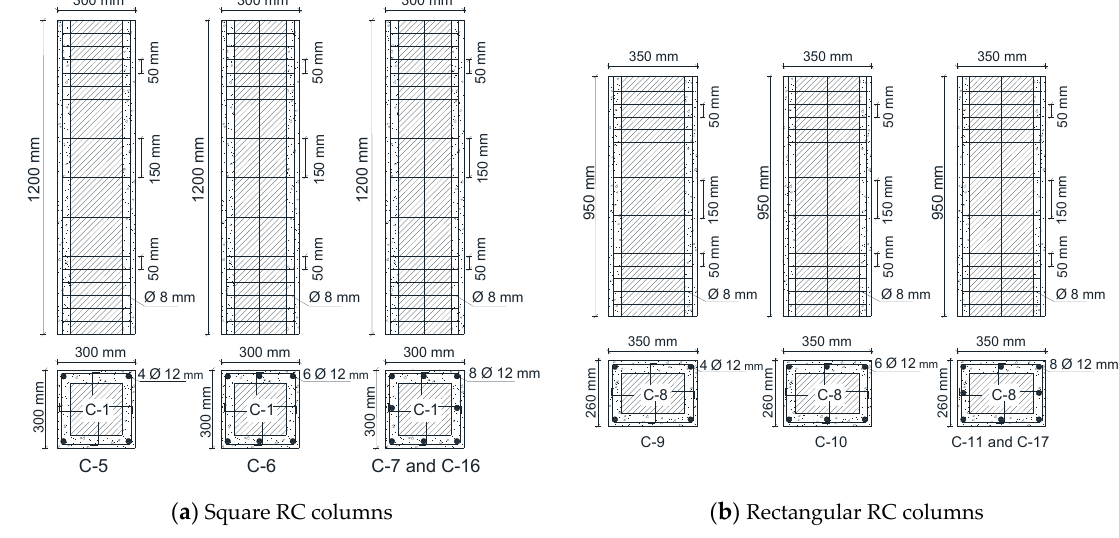
Figure 2. Details of the RC columns strengthened by complete RC jacketing.